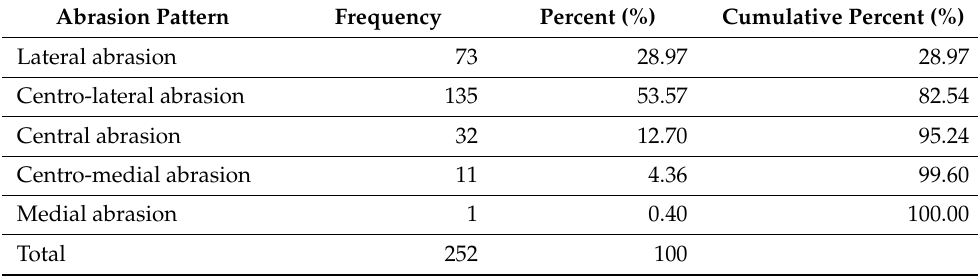
Table 7. Frequency analysis results of right shoe